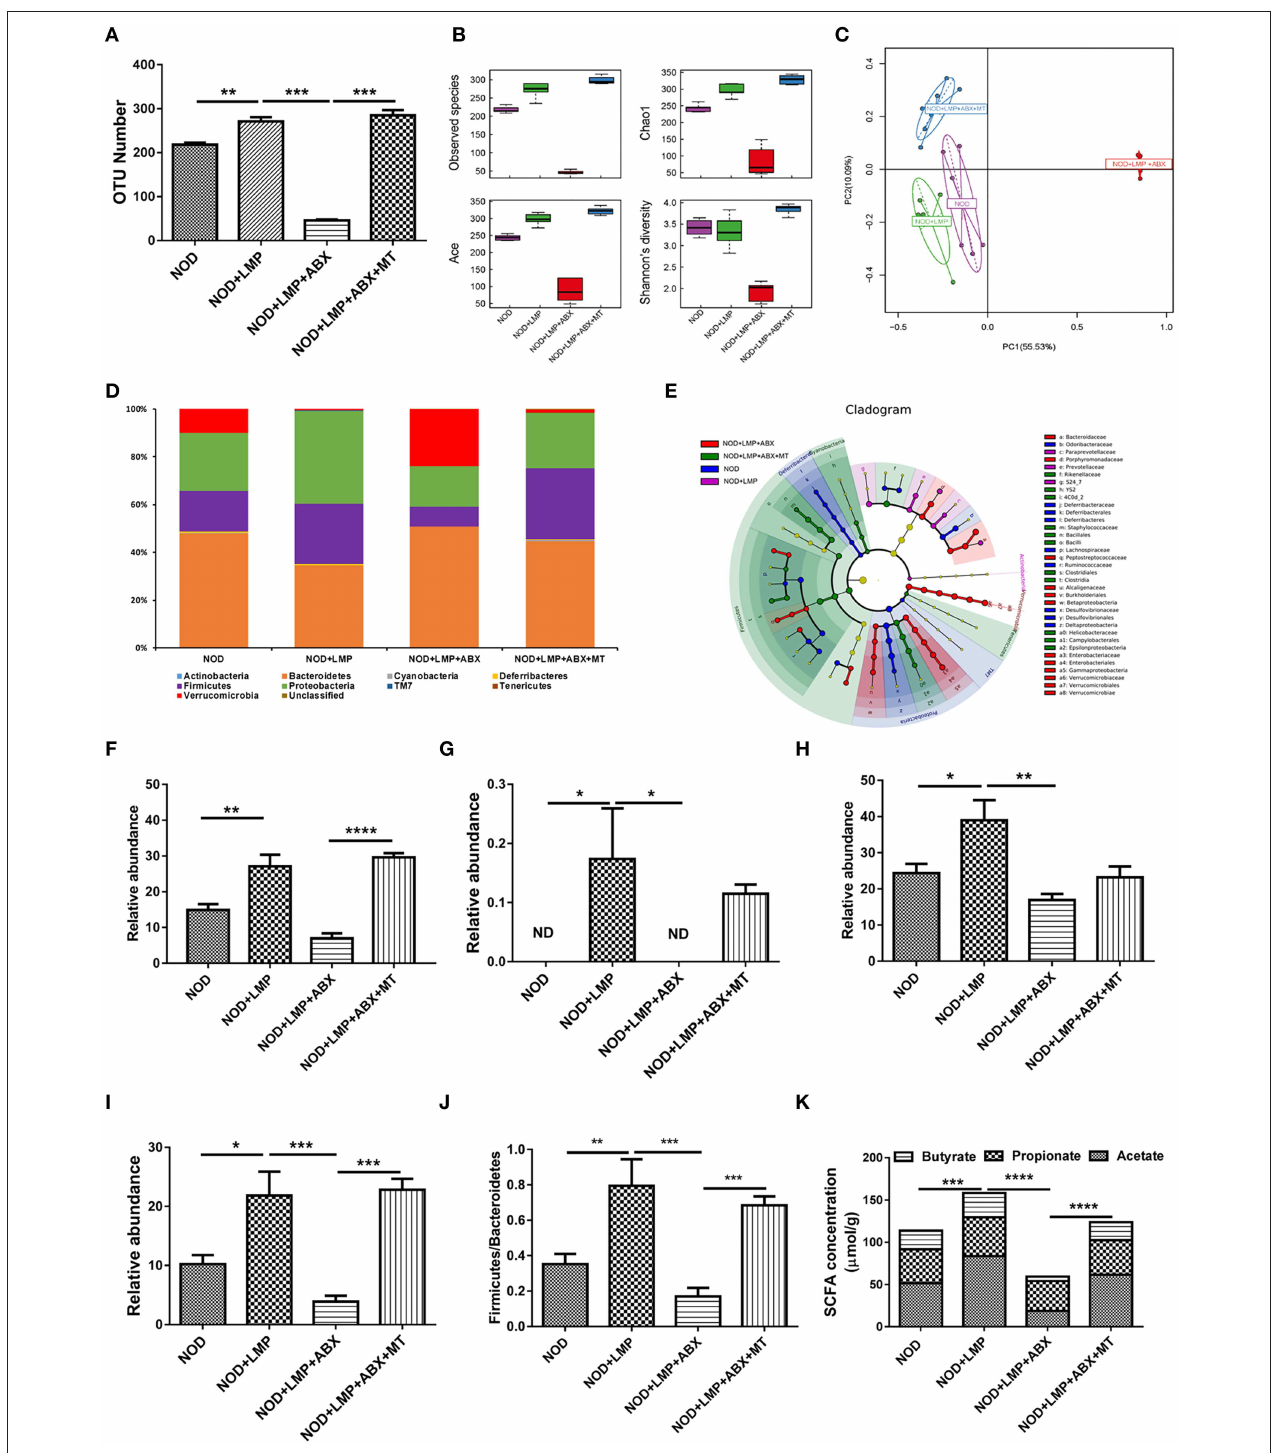
FIGURE 5 | LMP prevents caecal dysbiosis of microbiota at onset of T1D. (A) The OTU Number among four groups of NOD mice after different treatments. (B) Alpha diversity indices among the four treated groups of NOD mice were displayed using boxplots. (C) Principal Component Analysis (PCA) analysis based on OTU abundance was shown. (D) The taxonomic composition distribution among four groups of phylum-level. (E) Cladograms generated by LEfSe indicate differences in taxa between different groups. (F–J) Relative abundance of Firmicutes (F) , TM7 (G) , Proteobacteria (H) , Clostridia (I) , and the ratio of Firmicutes/Bacteroidetes (J) were shown. (K) Acetate, propionate, butyrate in caecal content were analyzed by GC-MS. Bars represent means ± SEM; * p < 0.05; ** p < 0.01; *** p < 0.001, and **** p < 0.0001; Each point represents one mice.